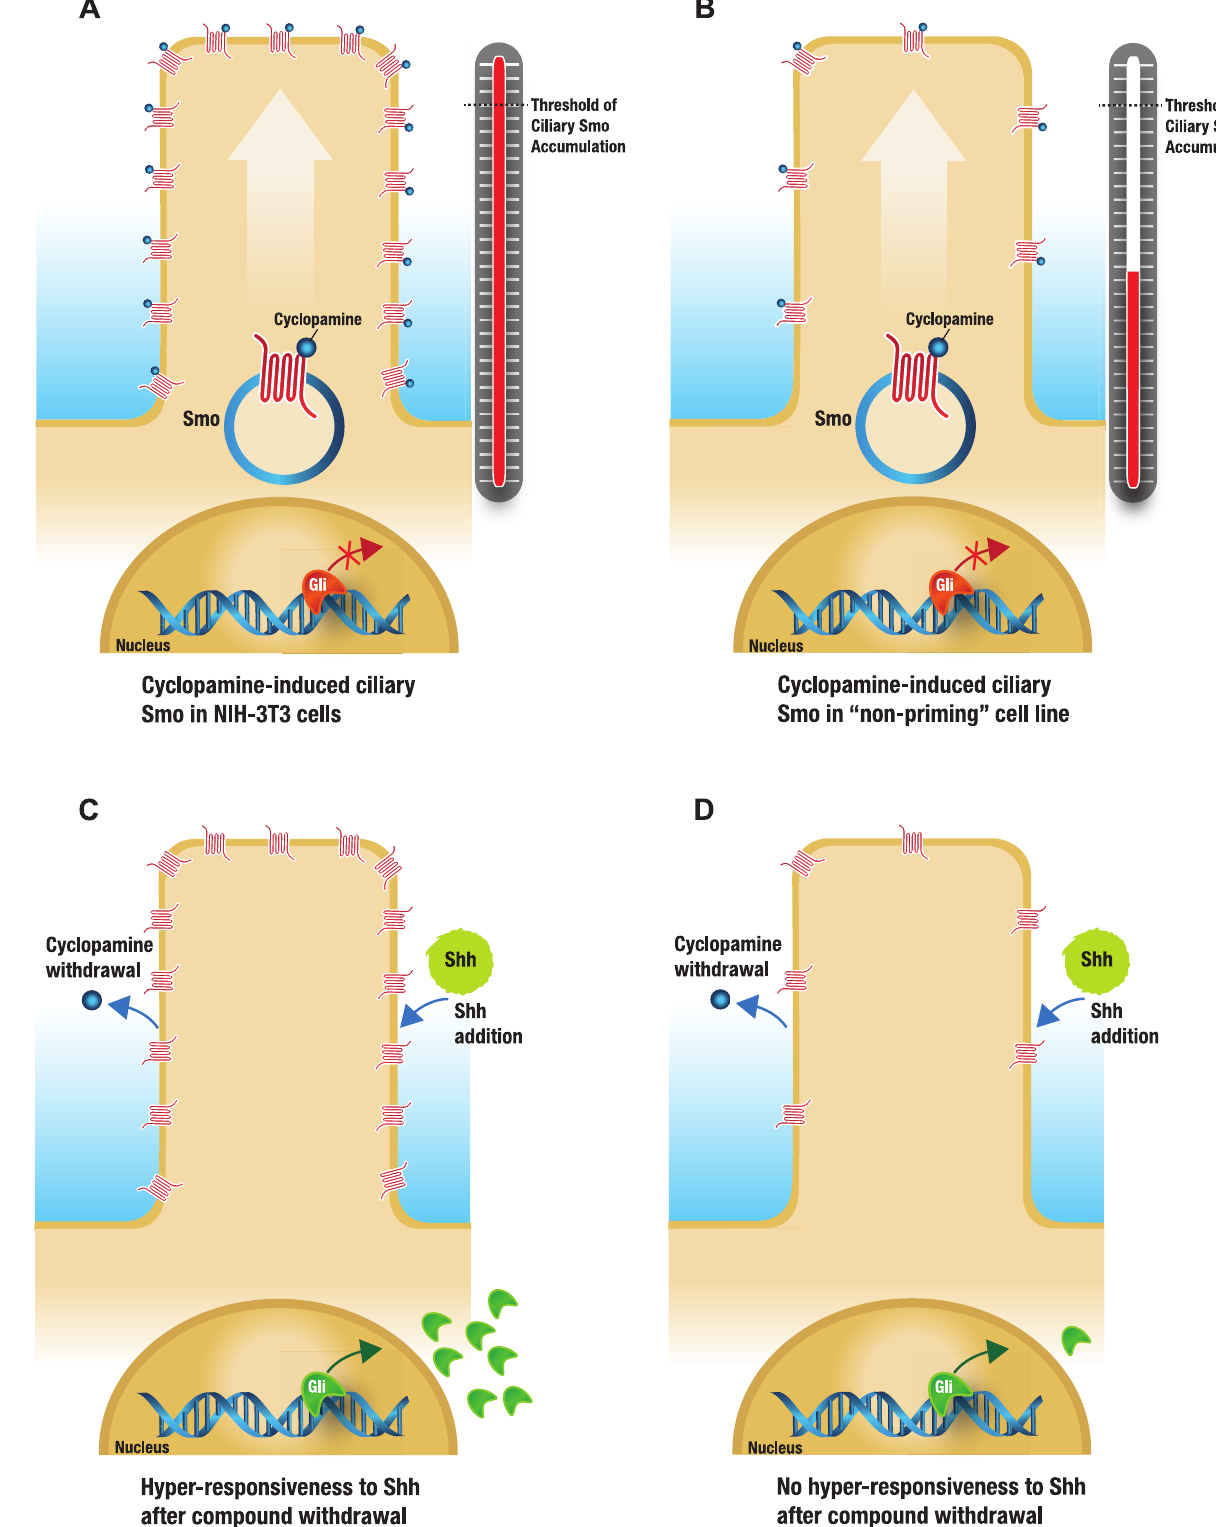
Figure 6. Model demonstrating threshold of Smo accumulation to PC necessary for priming effect. Cyclopamine induces ciliary Smo localization to a threshold necessary for priming activity to occur as observed in NIH-3T3 cells (A). In cell lines such as HEPM or C3H10T1/2, cyclopamine does not induce ciliary Smo localization to this threshold level (B). Upon cyclopamine withdrawal, followed by Shh addition, hyper- responsiveness as measured by Gli1 up-regulation is only observed in NIH-3T3 cells (C) and not cell lines where the required level of ciliary Smo accumulation was not achieved by cyclopamine pre-treatment (D).